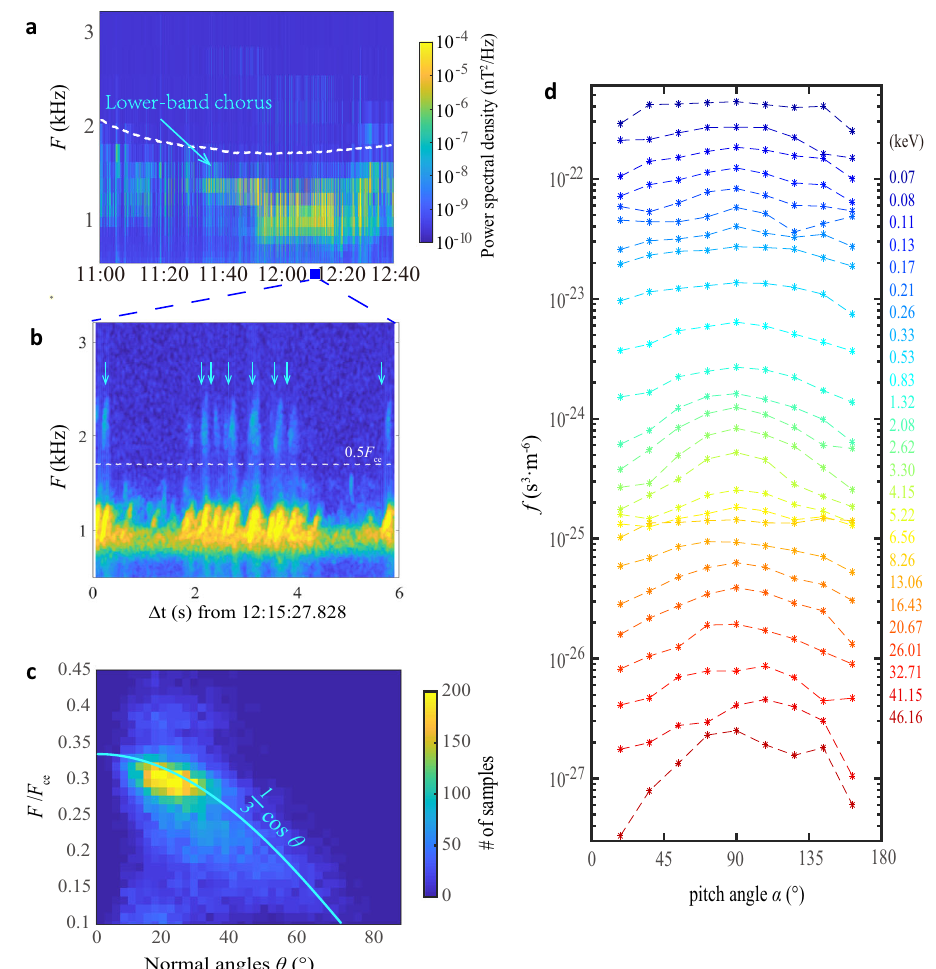
Fig. 1 | Van Allen Probe observations of diffuse auroral precipitation event on 14January2013.a , b choruswavepowerspectraldensitiesinthesurveyandburst modesmeasuredbytheVanAllenProbeA.Thedashedwhitelinesin a and b denote one-half electron gyrofrequencies ( F ce ), while light blue arrows in b indicate the second-harmonic emissions self-consistently generated by lower-band chorus waves. c Statistical survey of the wave frequency and normal angles of the lower-